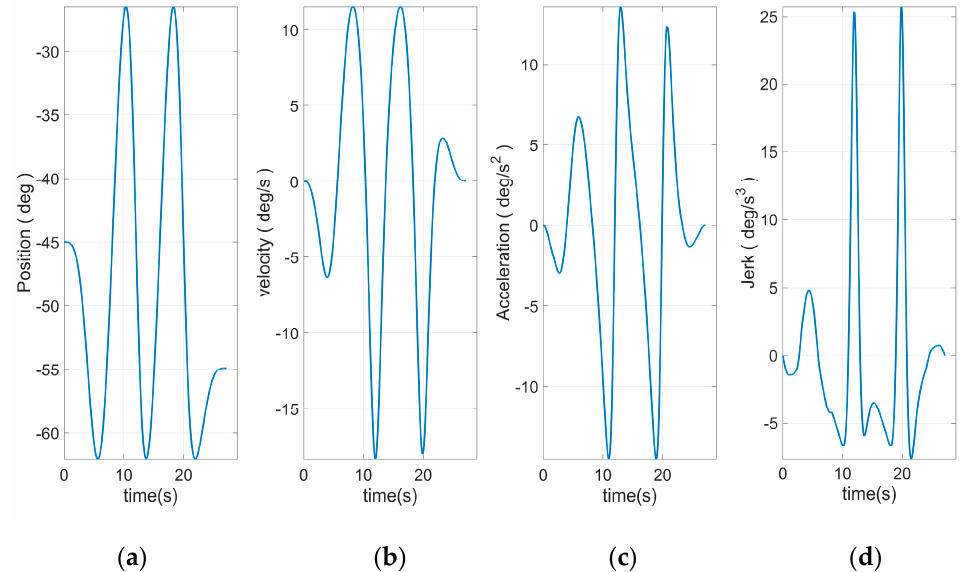
Figure 16. ( a ) Displacement of axis VI over time. ( b ) Velocity of axis VI over time. ( c ) Acceleration of axis VI over time. ( d ) Jerk of axis VI over time.